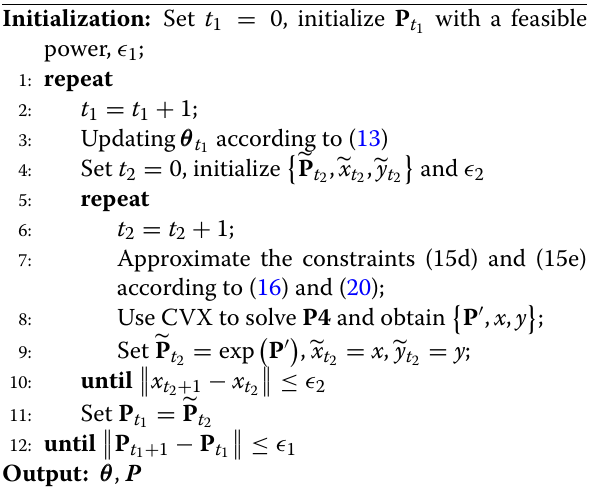
Algorithm 1 Proposed algorithm based on alternate opti- mization and